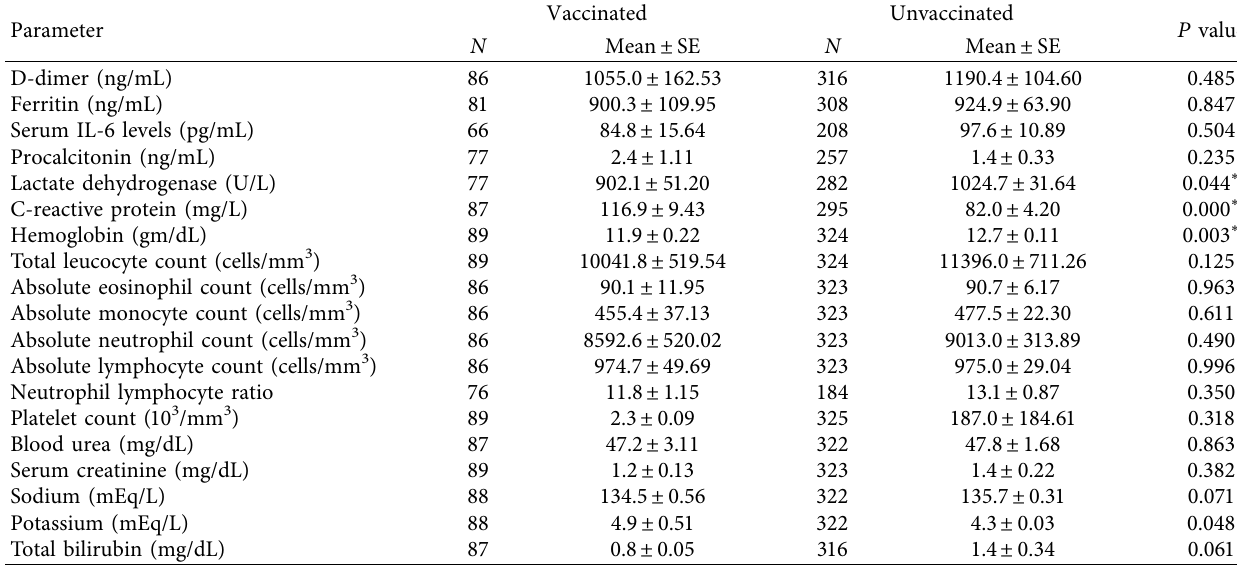
Table 2: Comparison of infammatory and laboratory parameters between vaccinated and unvaccinated using t test. Parameter